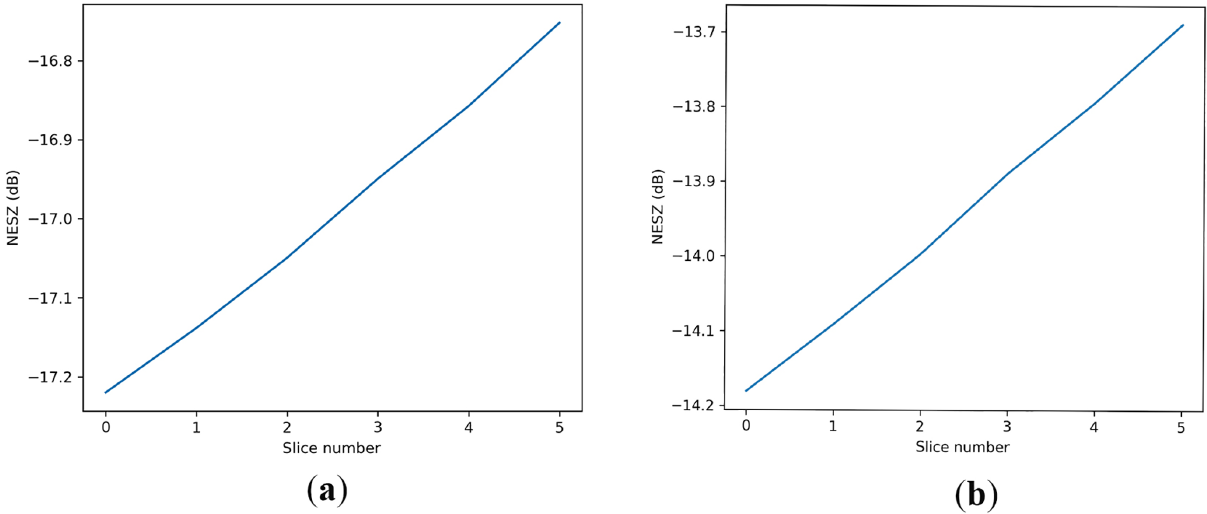
Figure 5. SeaWinds NESZ distribution as a function of slice number. (a) Ku-band HH polarization. (b) Ku-band VV polarization.